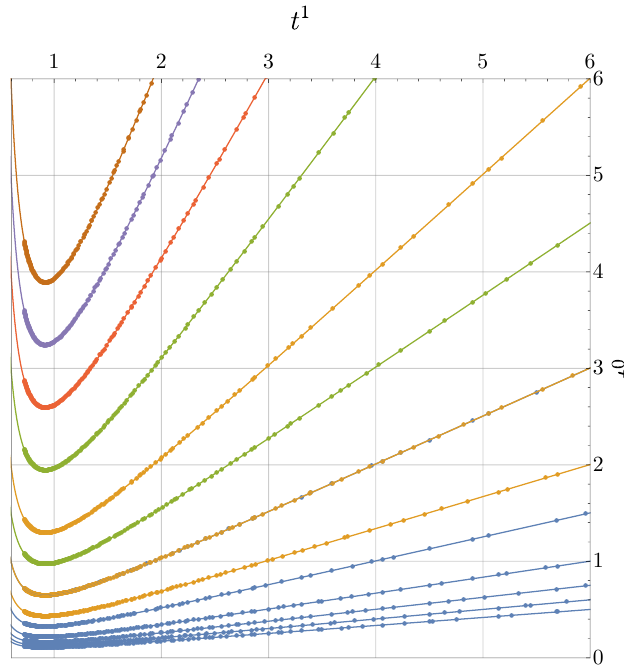
Figure 3 . This plot shows the locations of the numerically generated IIB1 vacua in the ( t 1 , t 0 ) -plane. The vacua are depicted with different colors corresponding to different values of ˆ f , with different A branches corresponding to different values for ˆ h B , present in the ensemble. For a given color, the expression (6.3) is displayed on top of the numerical data. We observe a perfect agreement. More precisely, the colors correspond to the following fluxes: blue: ˆ f = 1 , ˆ h B = 1 , . . . , 6 ; orange: A ˆ ˆ ˆ ˆ ˆ ˆ ˆ ˆ f A = 2 , h B = 1 , . . . , 3 ; green: f A = 3 , h B = 1 , 2 ; red: f A = 4 , h B = 1 ; purple: f A = 5 , h B = 1 ; and Brown: ˆ f = 6 , ˆ h B = 1 . As explained in section 6.3, vacua with ξ < 0 . 17 i.e. with t 1 , t 2 & 1 A